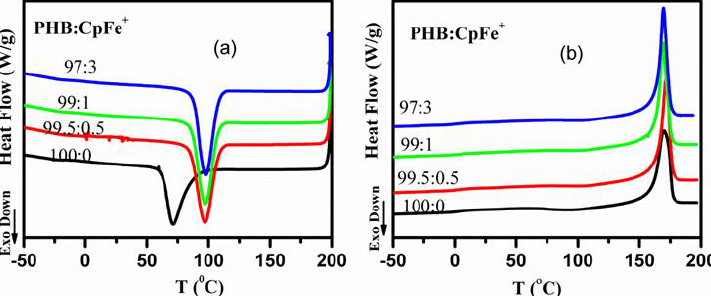
Figure 5. DSC curves of the pure PHB and PHB/CpFe + nanocomposites; ( a ) cooling curves from the melt at a cooling rate 20 °C/min, ( b ) second heating curves with a heating rate 20 °C/min.